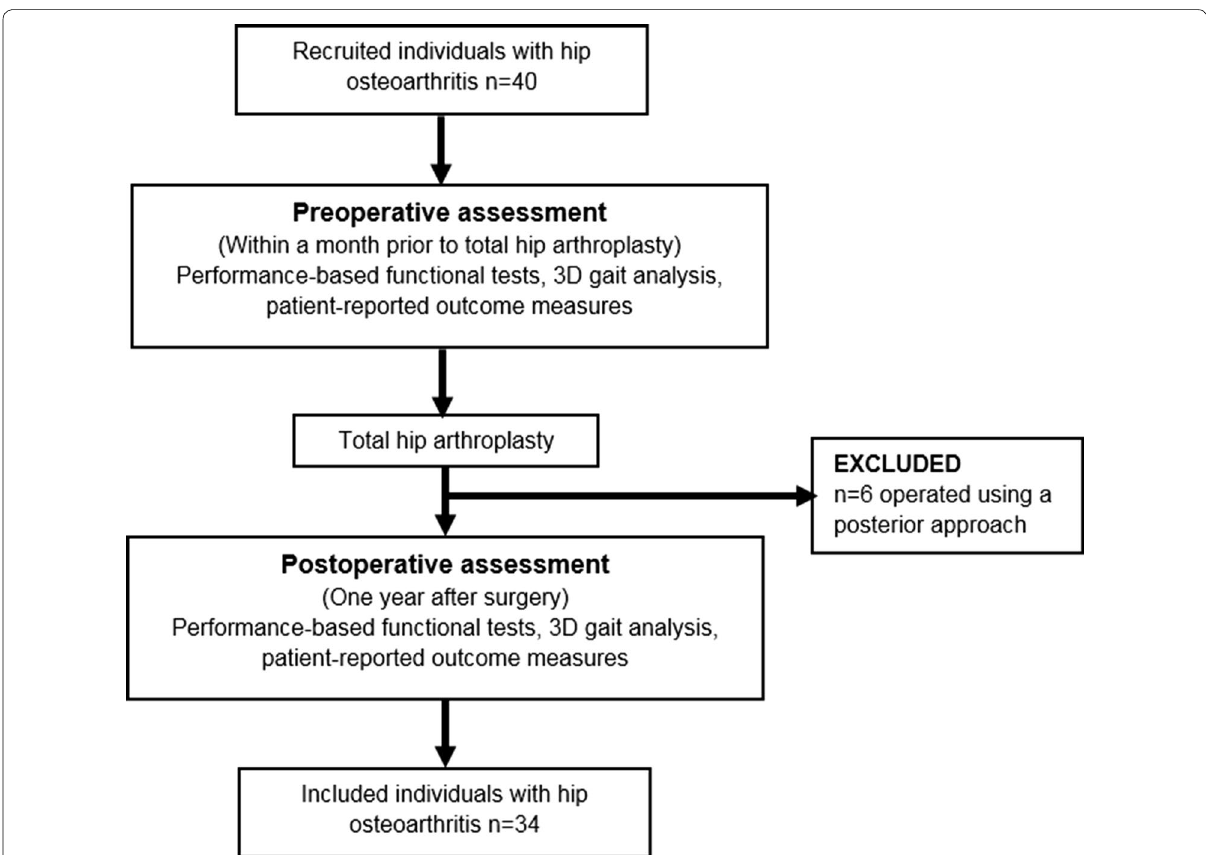
Fig. 1 Flowchart of included study participants with hip osteoarthritis, test procedures, excluded individuals, and study participants completing the 1-year